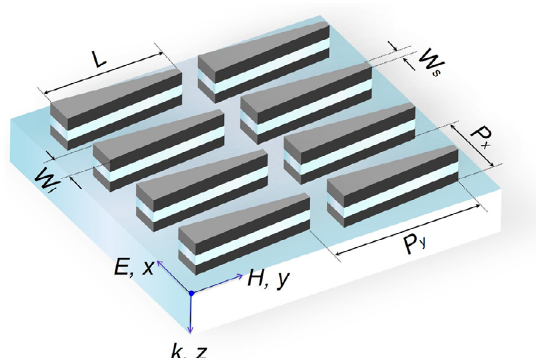
Figure 1. Schematic drawing of trapezoid-shaped triple-layer (Ag- SiO 2 -Ag) nanorod array on glass substrate with geometric param- eters of P x = 200 nm, P y = 1000 nm, W s = 40 nm, W l = 150 nm and L = 800 nm. The triple-layer nanorod thickness is 30 nm (Ag), 40 nm (SiO 2 ) and 30 nm (Ag), respectively. Broadband white source is normally (along z -axis) incident onto the sample surface with the electric-field polarized along x